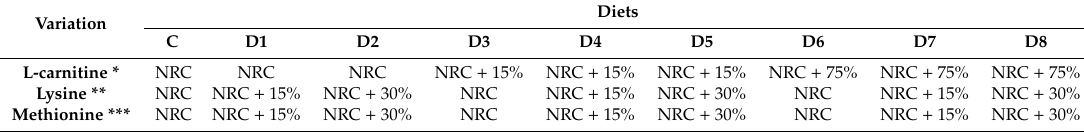
Table 2. Amount of L-carnitine, lysine and methionine in nutrient analysis of studied treatments.